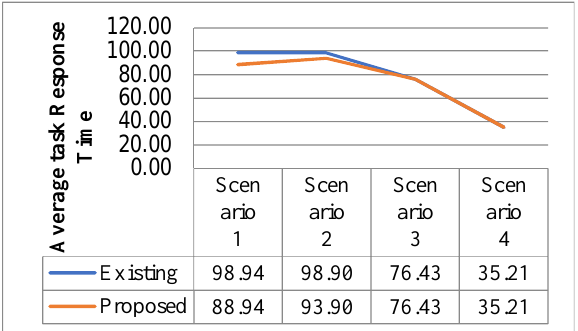
Figure 2. Comparison of existing & proposed